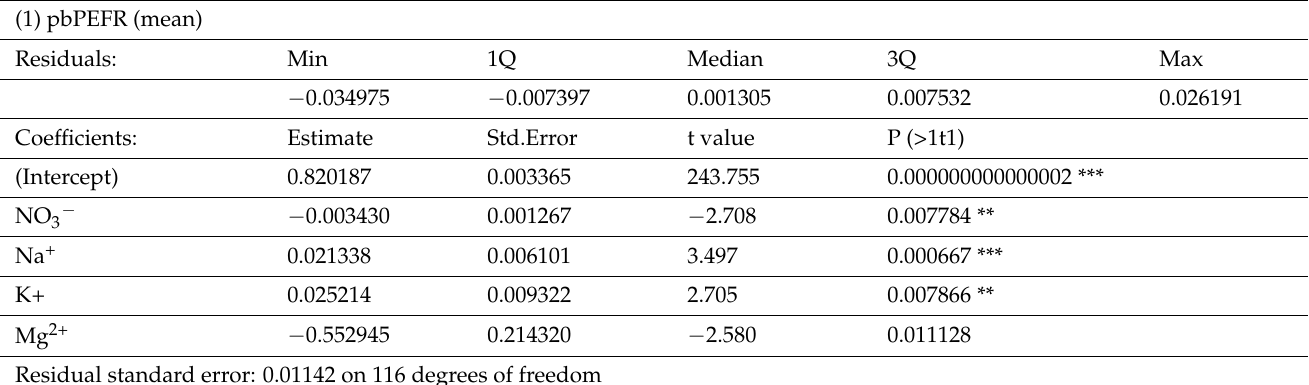
Table 3. Results of multivariate analysis of mean evening personal best peak expiratory flow